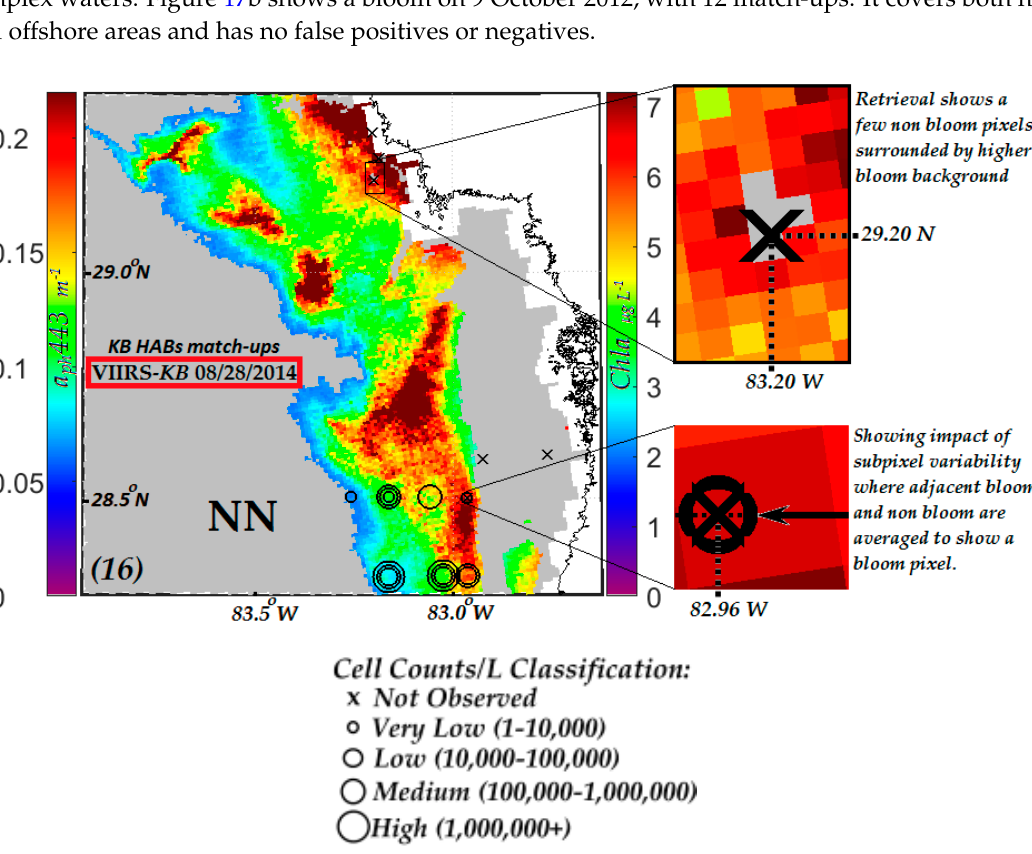
Figure 16. VIIRS-NN KB HABs retrievals for blooms date (28 August 2014), showing bloom compatible a ph 443 and equiv. [ Chla ] values. Notes image are overlaid with cell counts for this date. White areas represent cloud cover or invalid data.